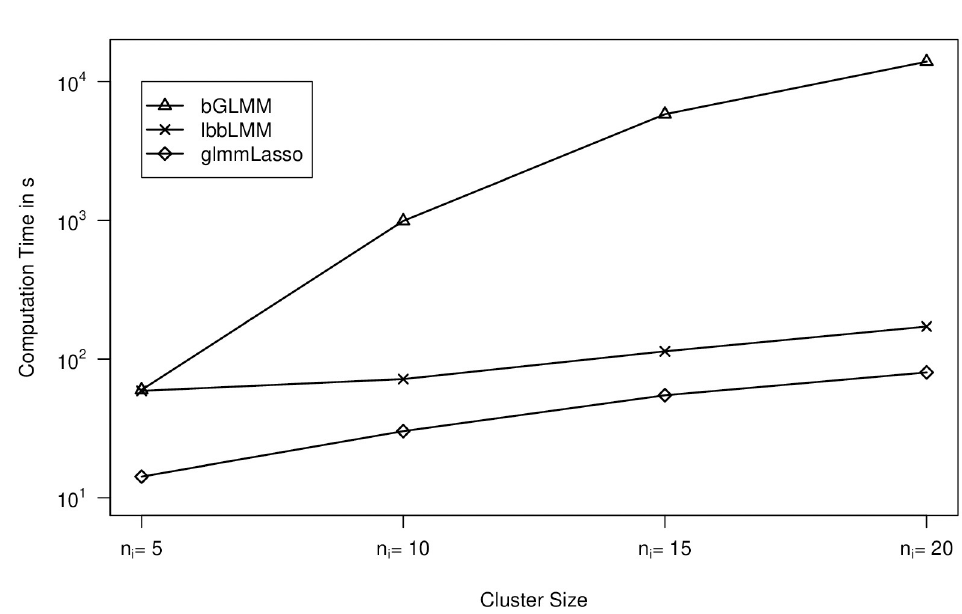
Fig 2. Differing computational effort of the regularization routines bGLMM , lbbLMM and glmmLasso for varying cluster sizes.